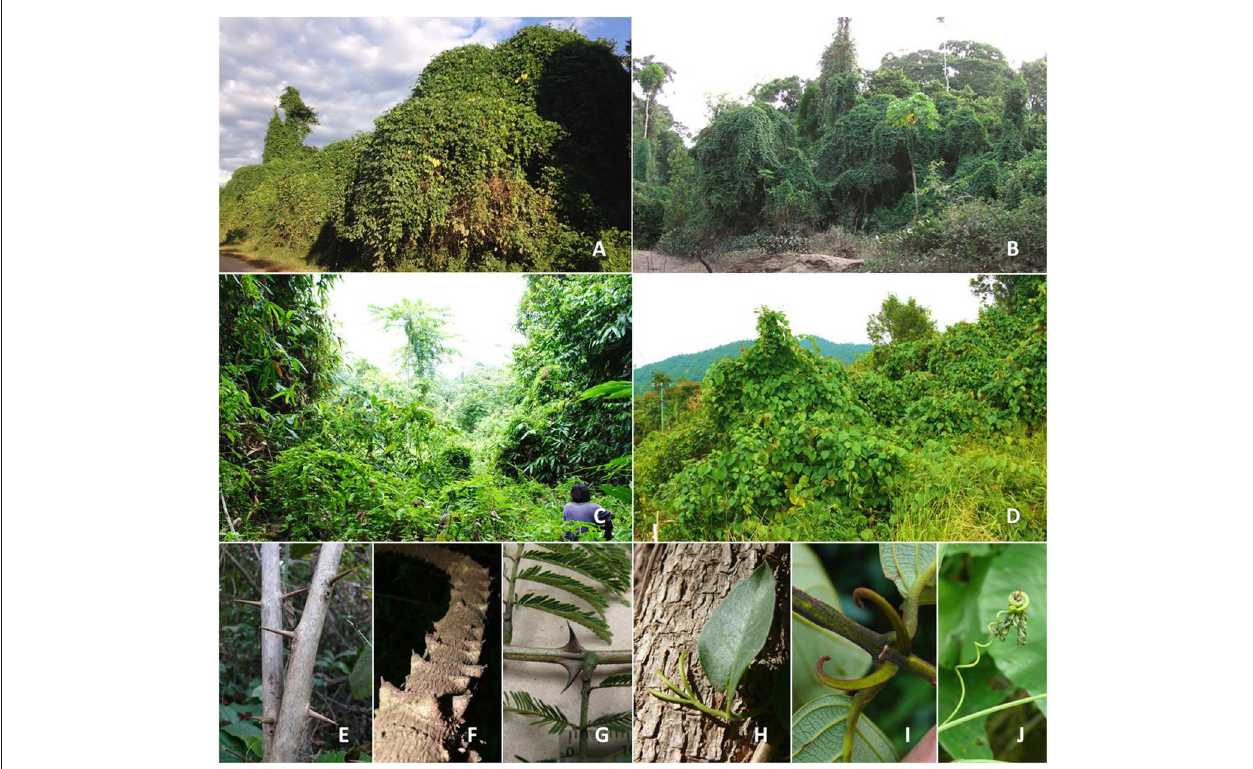
FIGURE 3 | Liana proliferation forming “blankets”, “towers” and “cones” over secondary forest across the tropics, including (A) Tanzania [30–40 years post-logging], (B) Amazon Basin [repeated riverside disturbance], (C) Malaysia [15–20 years post logging], and (D) Australia [repeated cyclone damage], are fastened tight by various forms of armature and stem adaptations, such as (E) simple spines or thorns; (F) prickles on bosses; (G) paired recurved spines; (H) 3-branched thorns; (I) hooked spines; (J) tendrils. Photographs by ARM, except for B (with permission from Stefan Schnitzer) and C